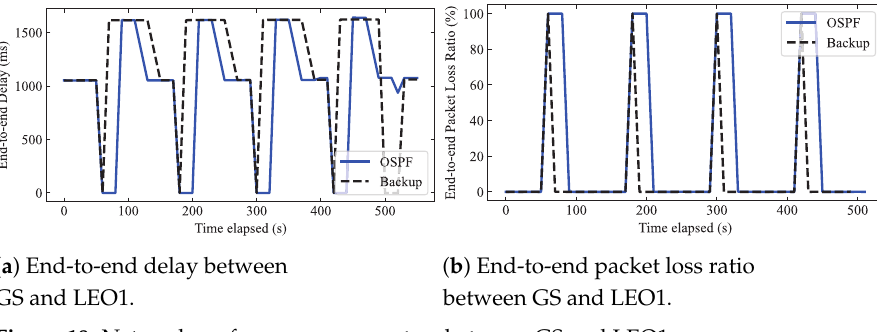
Figure 18. Network performance parameters between GS and LEO1.